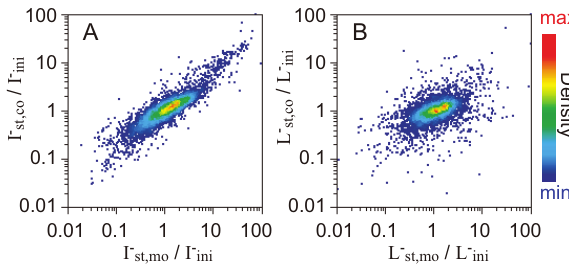
Figure 3. Population dynamics of the membrane coculture and re-coculture. (A) Identical dynamics between the membrane coculture (red circle for I – and green triangle for L – ) and the coculture without the membrane (red square for I – and green diamond for L – ). For the membrane coculture, I – and L – cells were inoculated into minimal media separated by a membrane, which was permeable to amino acids but not to E. coli . (B–G) The time course of the cell concentration in the re-coculture. For all re-cocultures, each sample of E. coli from mid- membrane culturing was washed with minimal media lacking amino acid supplements, and then mixed at an initial concentration of 10 6 /ml for both strains. The conditions for I – and L – cells used for each re- coculture is indicated on the graphs, where the subscripts ‘‘ini,’’ ‘‘co,’’ and ‘‘mono’’ refer to 0 h of membrane culture, 23 h of membrane coculture, and 23 h of membrane monoculture, respectively (see the text for details). An initial increase in the cell concentration of I – cells without the lag phase was observed only in the coculture containing L – co cells (depicted by arrows). Closed and open symbols represent replicates of two individual cultures.